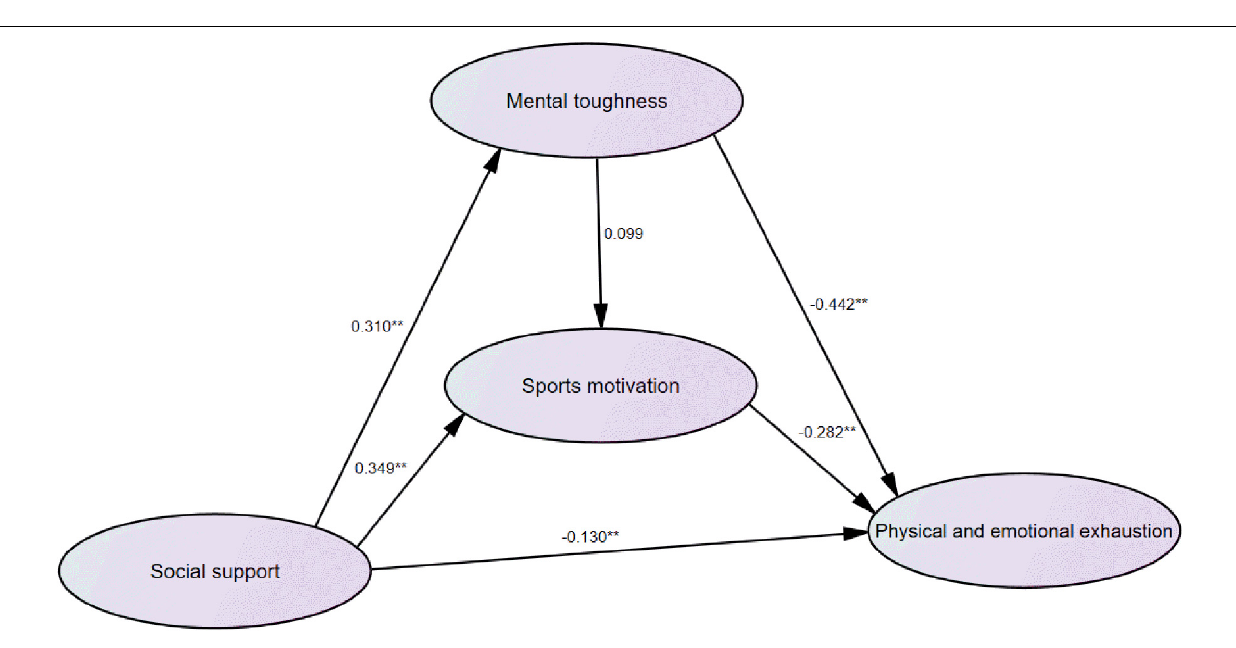
FIGURE 2 | Schematic diagram of path analysis of social support, sports motivation, mental toughness, and reduced sense of achievement. **P < 0.01.